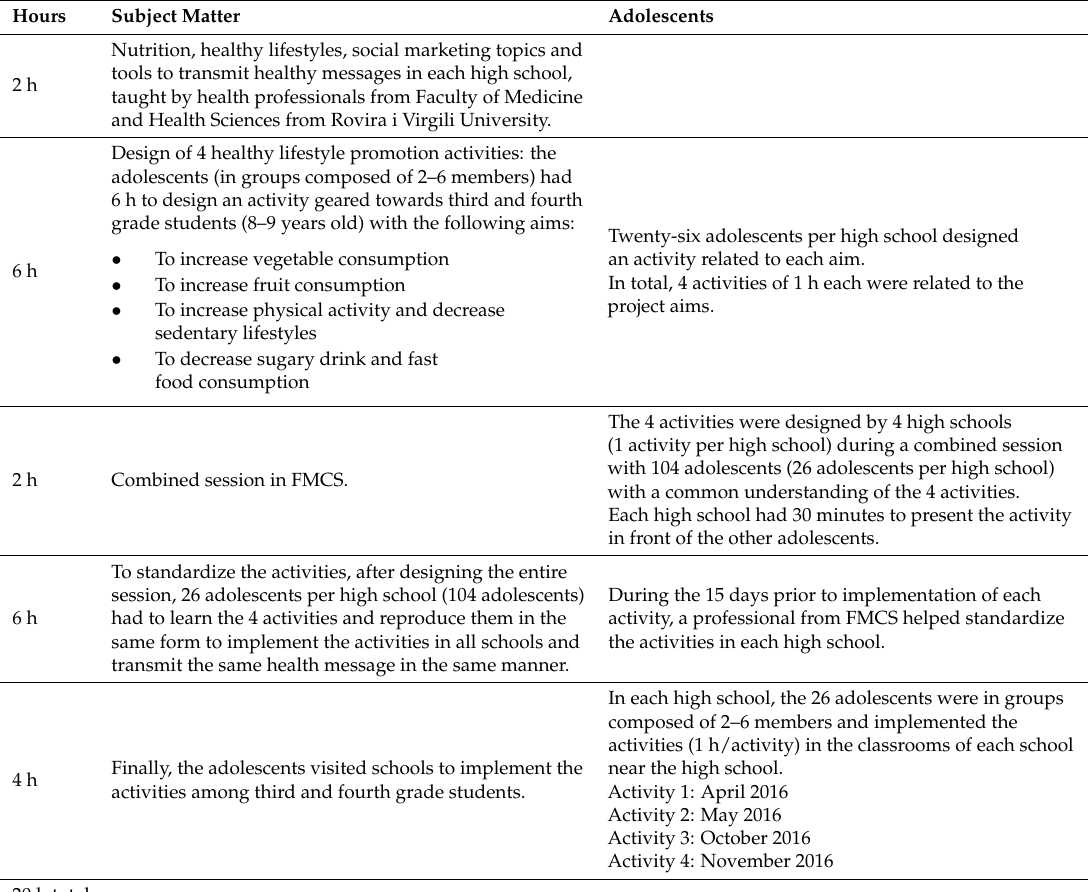
Table 1. Training of adolescents in high schools and implementation of activities in primary